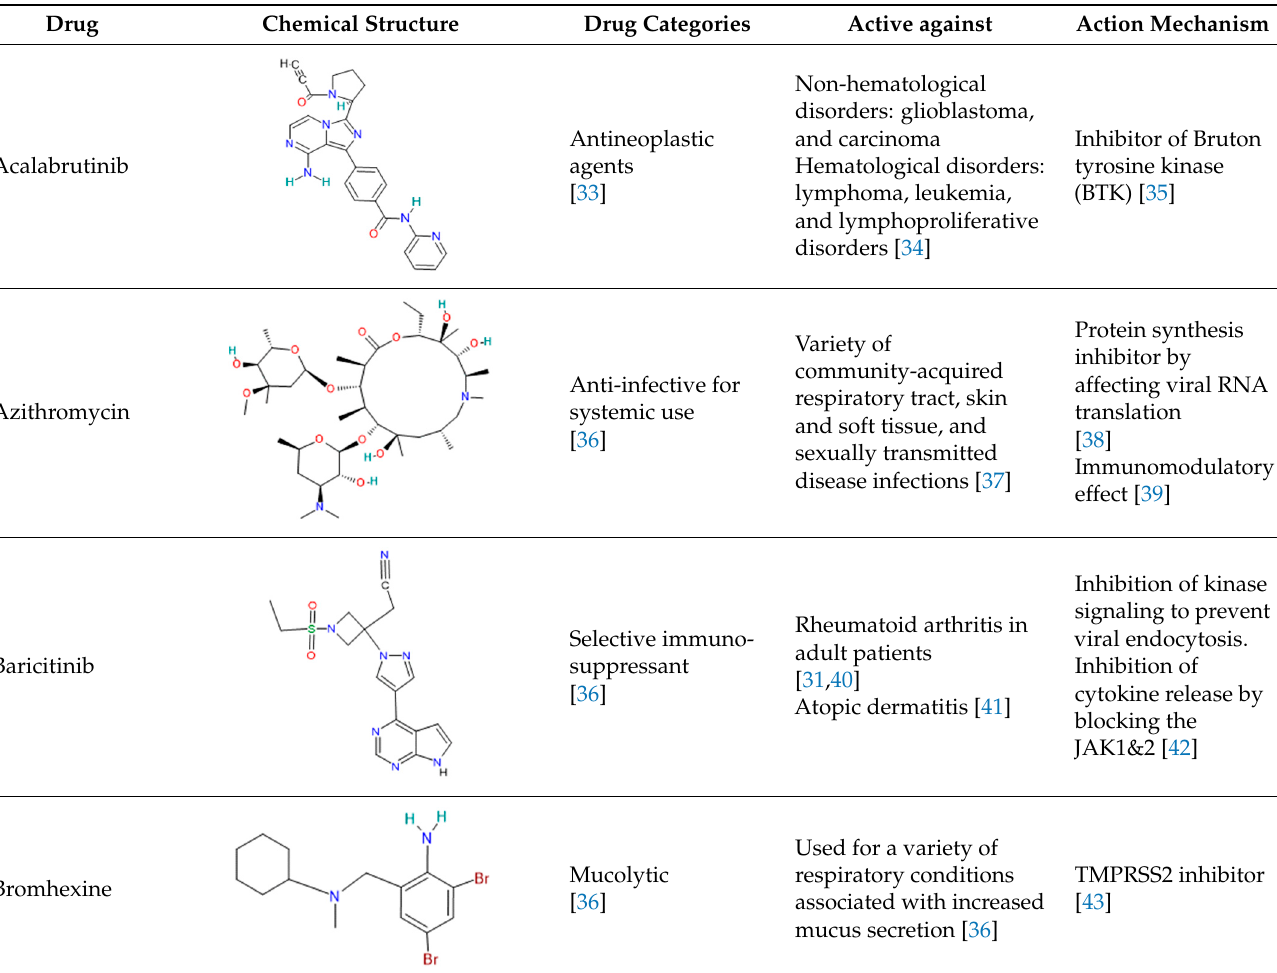
Table 1. Drugs used in the treatment against COVID-19 infection.